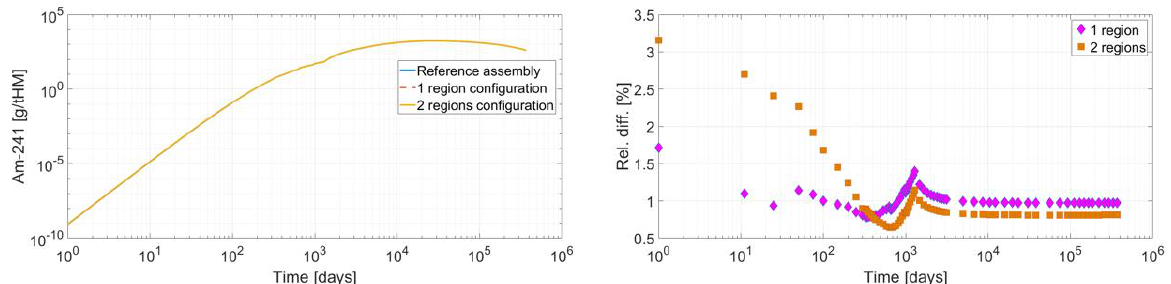
Figure 13. 241 Am mass as a function of irradiation + subsequent cooling time for different assembly configurations with respect to the reflector.